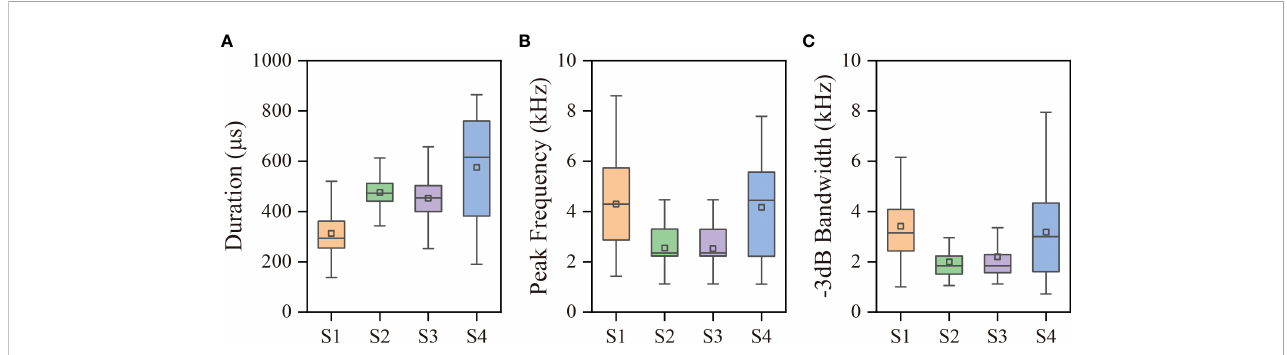
FIGURE 4 The comparisons of snap (A) Duration, (B) Peak frequency, and (C) -3dB bandwidth across the recording sites, where the box bottom and top denote the 25% and 75% percentile of the distribution, and the line extensions of the box represent the lower and upper edge values, respectively. The median and mean are represented by the line and square inside the boxes,